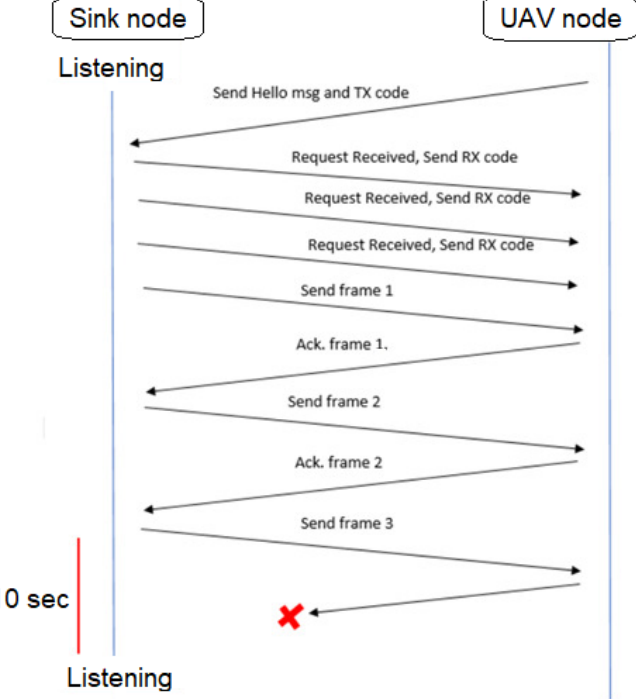
Figure 12. The sink to UAV data flow